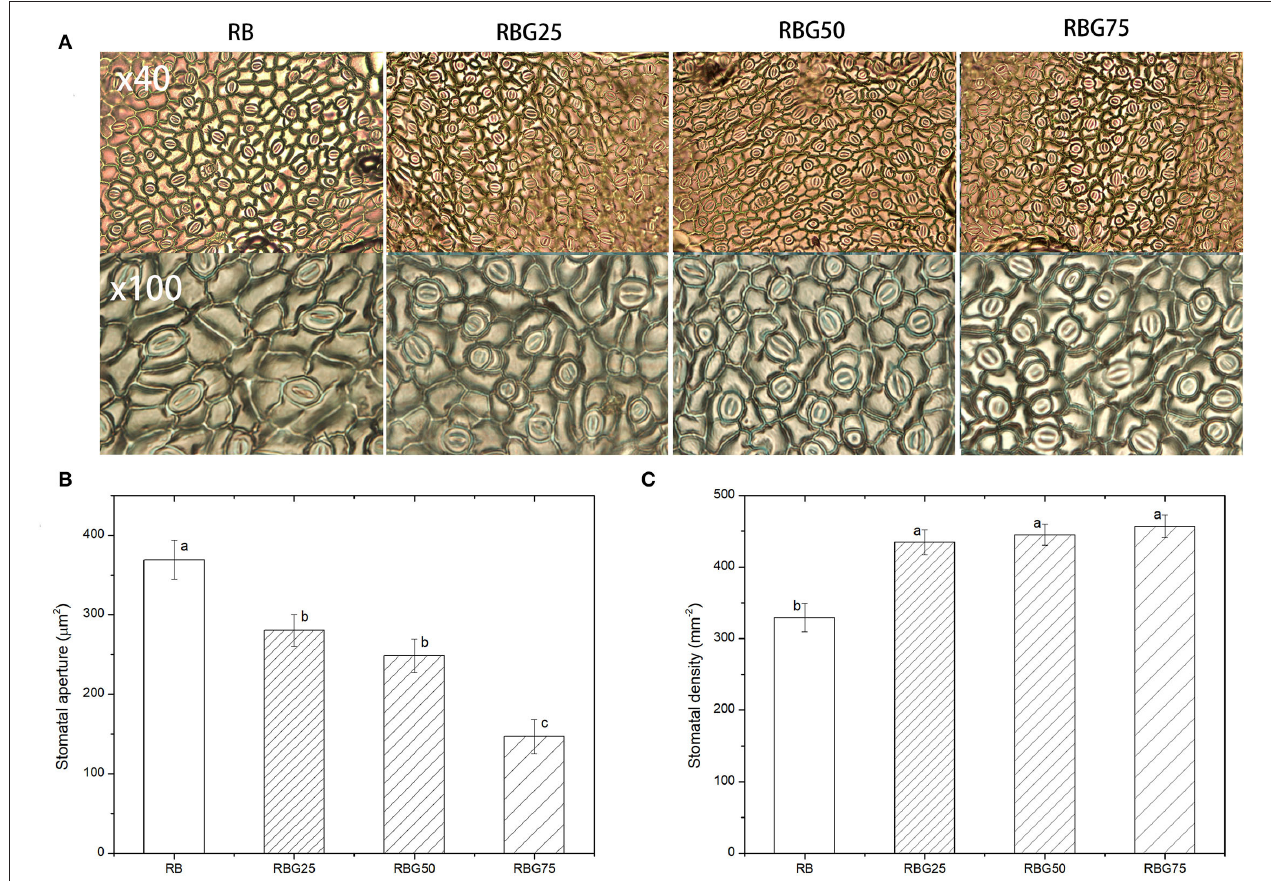
FIGURE 7 | Effect of different spectral conditions on stomatal characteristics of cucumber leaves after 9 days drought stress. (A) Images of stomatal. The photos at the top ( × 40) are 40 times magnified replica of the stomata. The photos at the bottom ( × 100) are 100 times enlarged replica of the stomata. (B) Stomatal aperture. (C) Stomatal density. RB, RBG25, RBG50 and RBG75 are the different spectral conditions, respectively. The data presented were the means ± SE ( n = 30). Different lowercase letters on the bar chart indicated significant differences among treatments according to Tukey’s test ( p <